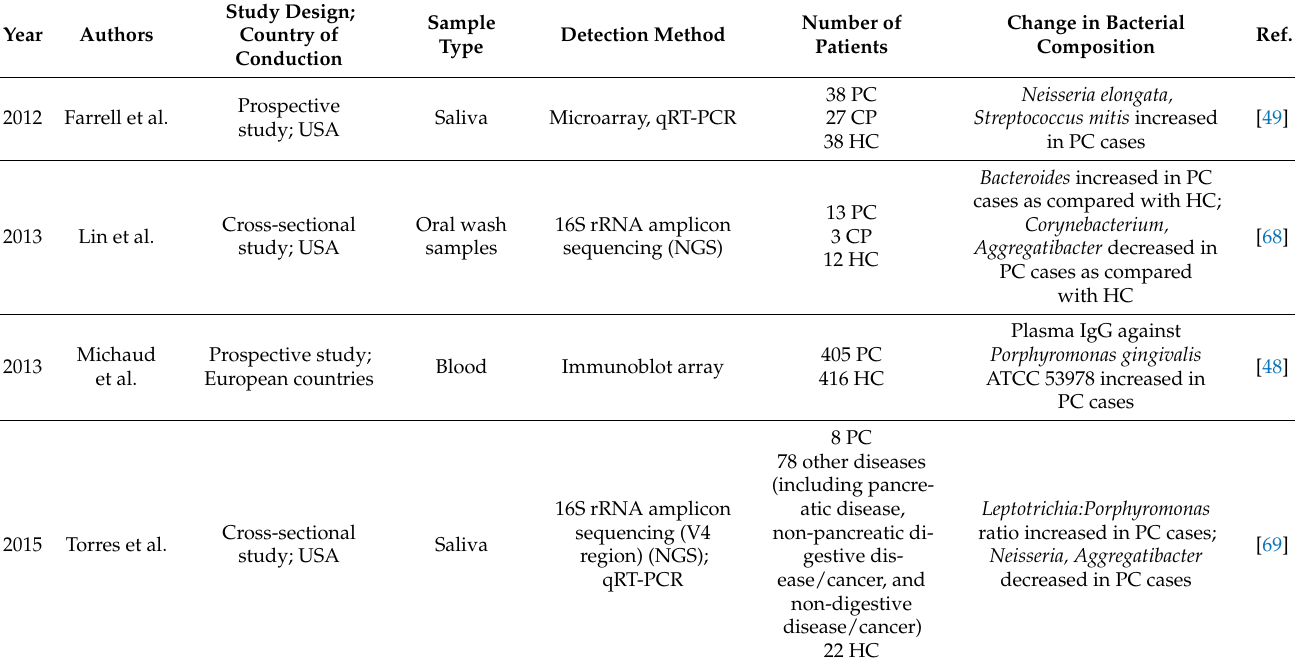
Table 2. Summary of studies regarding the oral, intestinal, and fecal microbiome of patients as a non-invasive biomarker for pancreatic